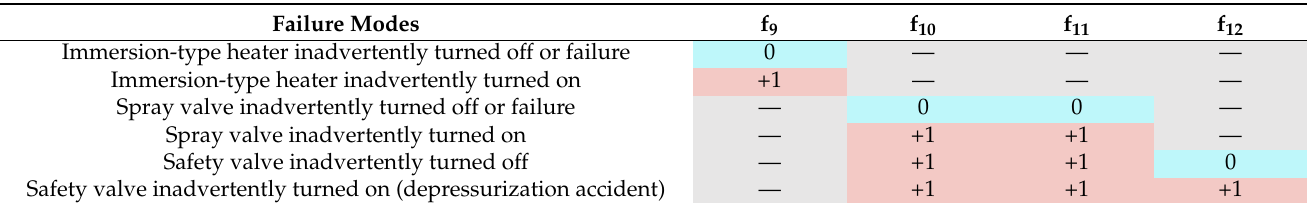
Table 6. The fault signature matrix of the pressurizer.